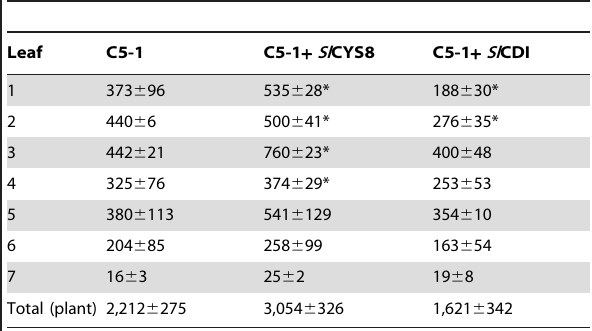
Table 1. Antibody product yield ( m g) per leaf and per plant in N. benthamiana plants transiently expressing C5-1, alone or along with Sl CYS8 or Sl CDI.